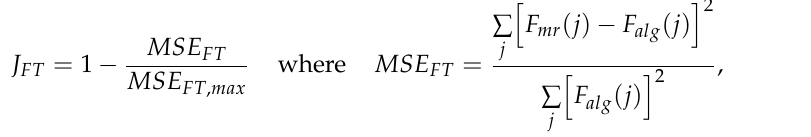
Table 2. Quality index J FT assessing the tracking of the desired control force F alg by the actual force generated by MR damper Bouc–Wen models F mr . Control configurations in bold correspond to the best quality index of trajectory linearity J TL . Location of MR Damper Model: J FT ∆ α alg Front Hor. Front Vert. Rear Hor. Rear